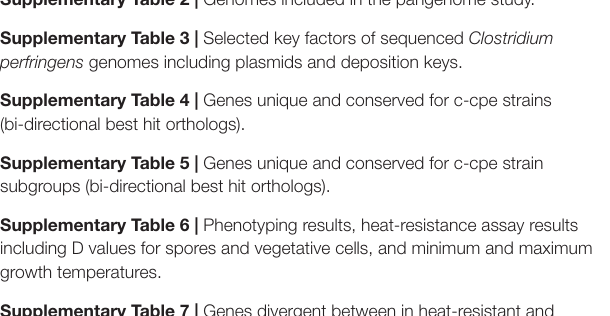
Supplementary Figure 1 | Phylogenetic tree of 290 C. perfringens